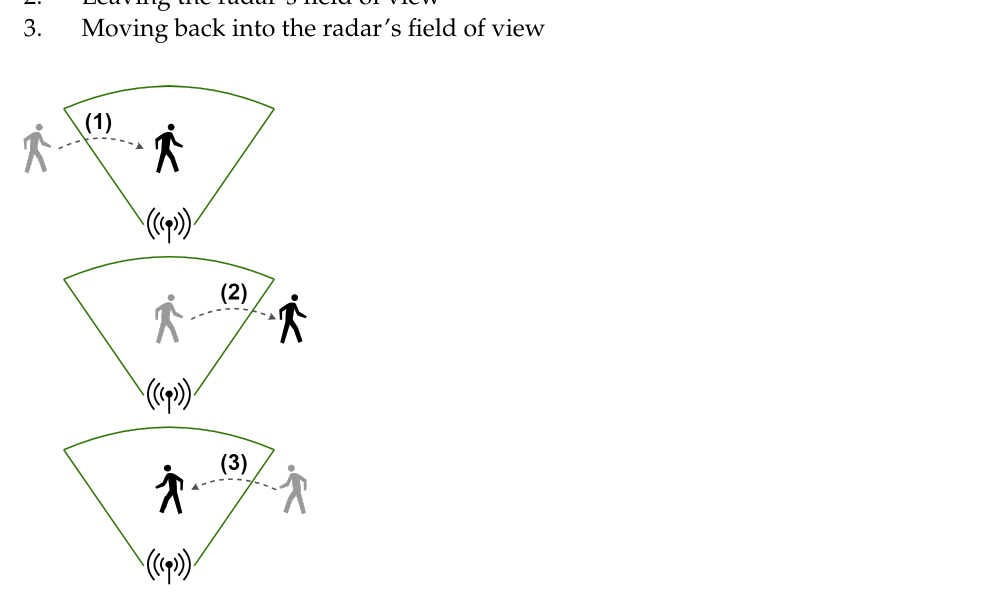
Figure 1. Discontinuous tracking scenario; An individual (1) moves into the radar’s field of view, (2) leaves the radar’s field of view and (3) moves back into the radar’s field of